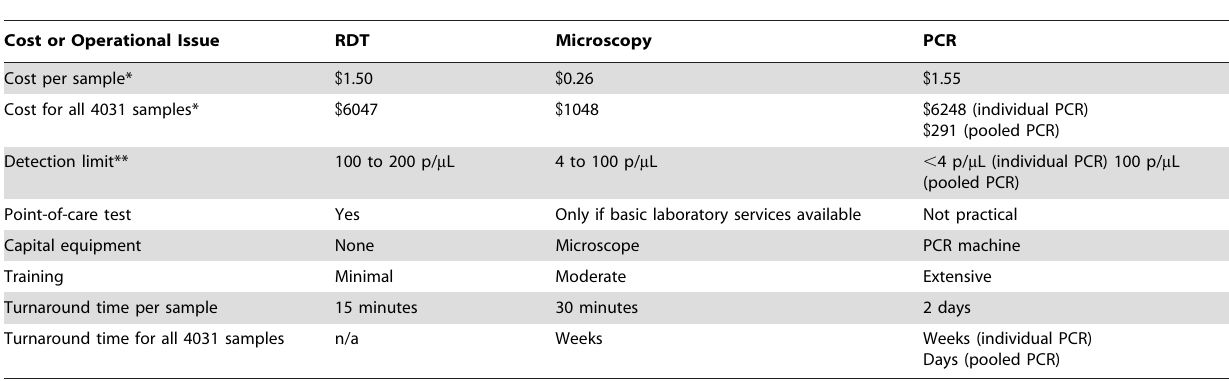
Table 3. Cost and operational comparisons between infection diagnostic